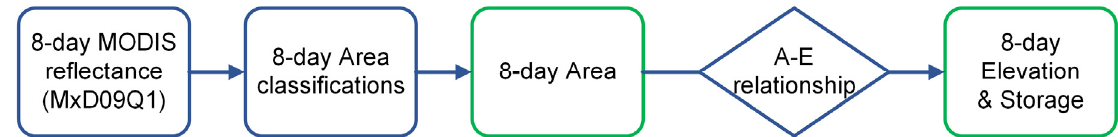
Figure 2. Flow chart of the algorithm for deriving the MxD28C2 product, which contains 8-day area, elevation, and storage results for the 164 reservoirs. The green boxes represent the product components.